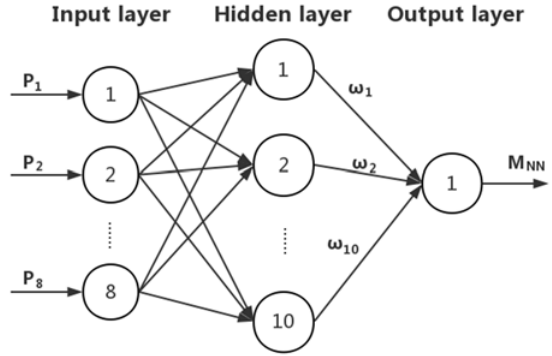
Figure 2. The back propagation neural network (BP NN) structure.